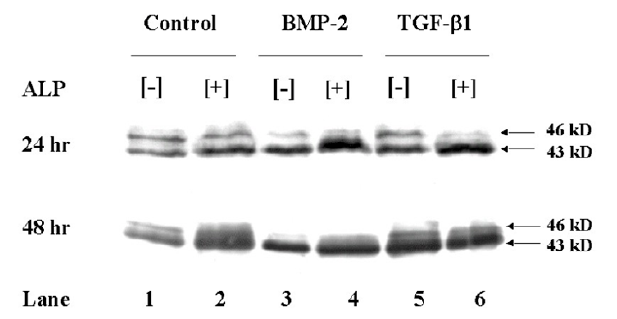
Figure 2 Effects of BMP-2 and TGF- β 1 on the expression and phos- phorylation of Cx43 protein. Western analysis of Cx43 pro- tein expression for control, BMP-2, and TGF- β 1 groups after treatment for 24 h (top panel) and 48 h (bottom panel) in the absence (-) or presence (+) of ALP. Experiments suggest that 43 kD and 46 kD bands represent the unphosphorylated and phosphorylated forms of Cx43, respectively.